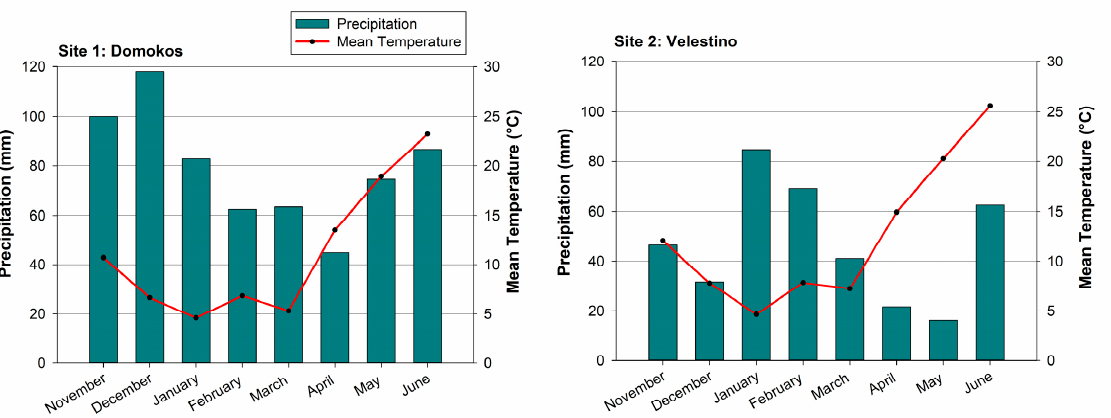
Figure 1. Weather conditions (mean air temperature and precipitation) throughout wheat’s growth period (November 2021 to June 2022) in both sites (Domokos and Velestino).